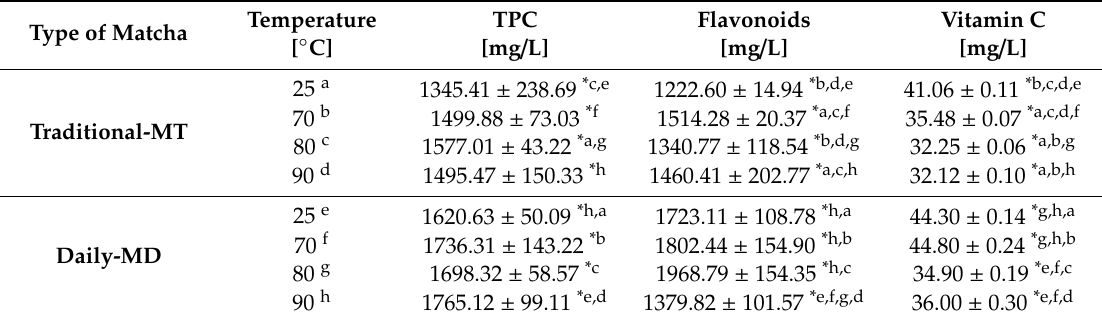
Table 2. The total polyphenols content (TPC), flavonoids and vitamin C in Matcha tea infusion (Traditional,